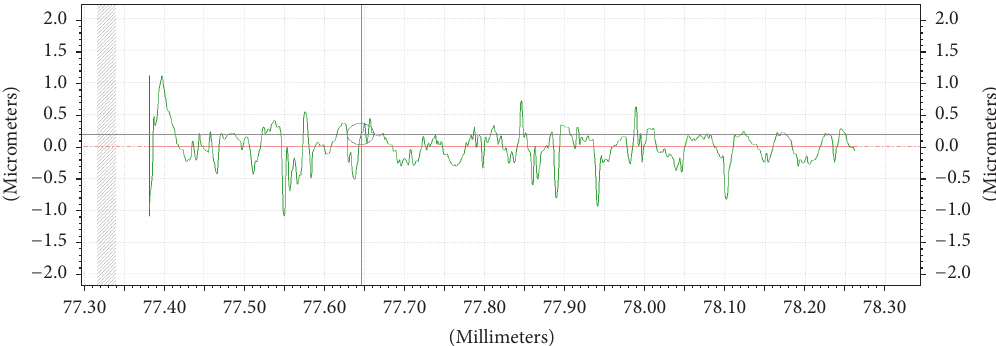
Figure 13: 2D surface roughness profile of machined Inconel 718 (parameters: temperature: 55 ∘ C, concentration: 600 g/L, and time: 40 minutes).